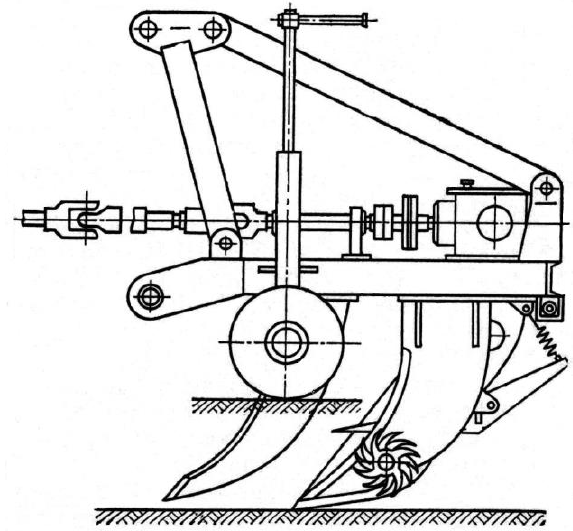
Figure 4. Intra-soil milling machine PMS-100.